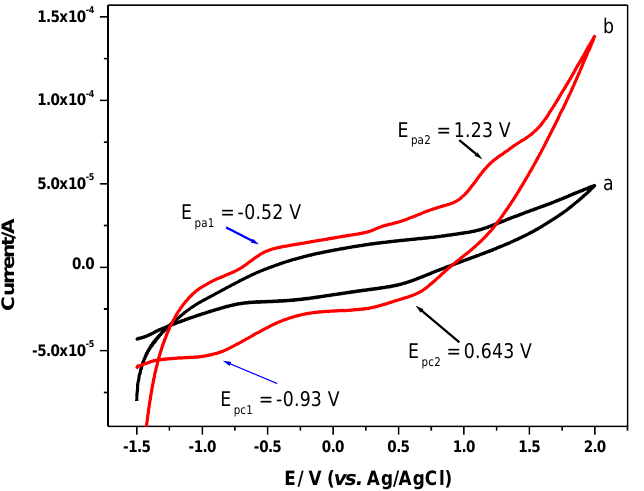
Figure 5. Cyclic voltammograms for Pt electrode in ( a ) the absence of compound 4 and ( b ) the presence of compound 4 in dichloromethane with 0.1 M TBAP using a 50 mV/s scan rate.